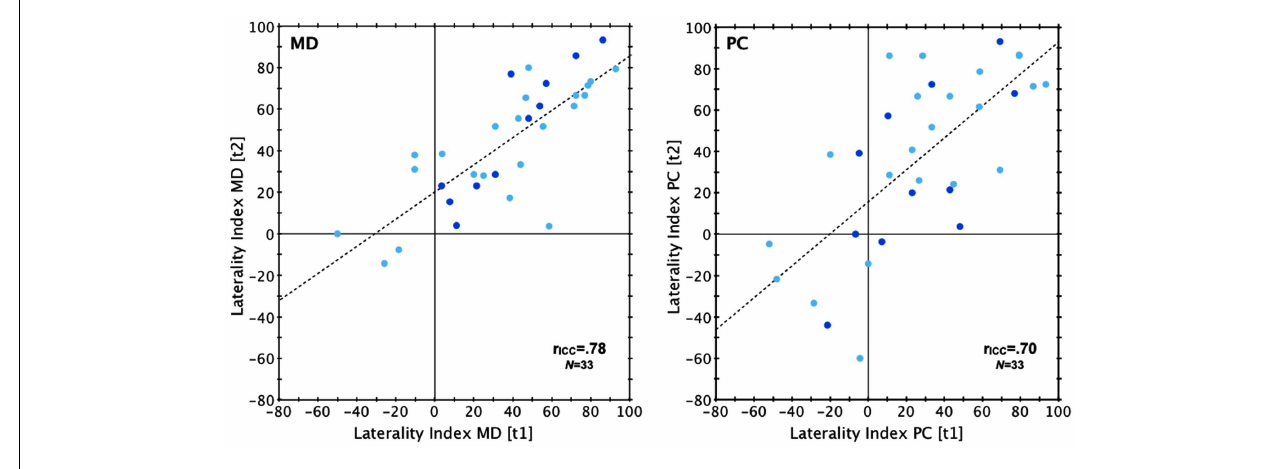
difference between correct LE and RE reports. r ICC , intraclass correlation coefficient. Dot color indicates sex: light blue, females; dark blue,